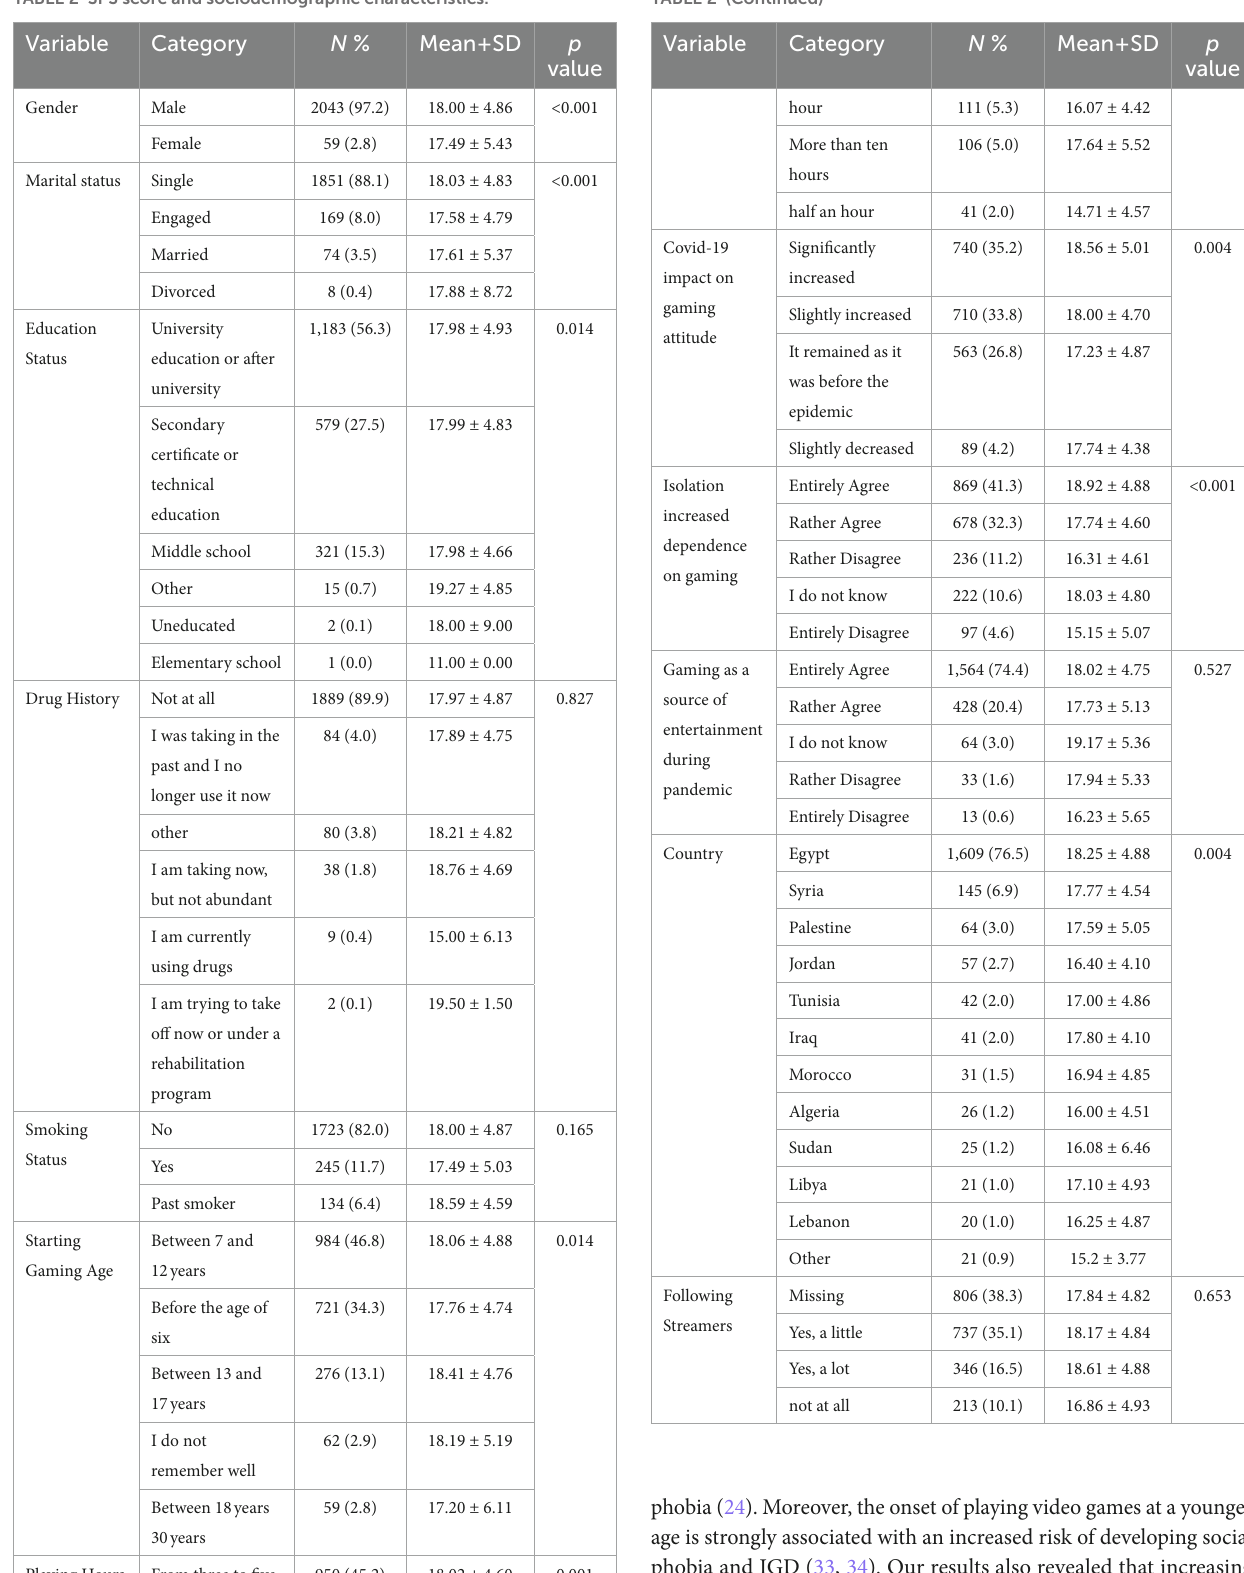
TABLE 2 SPS score and sociodemographic